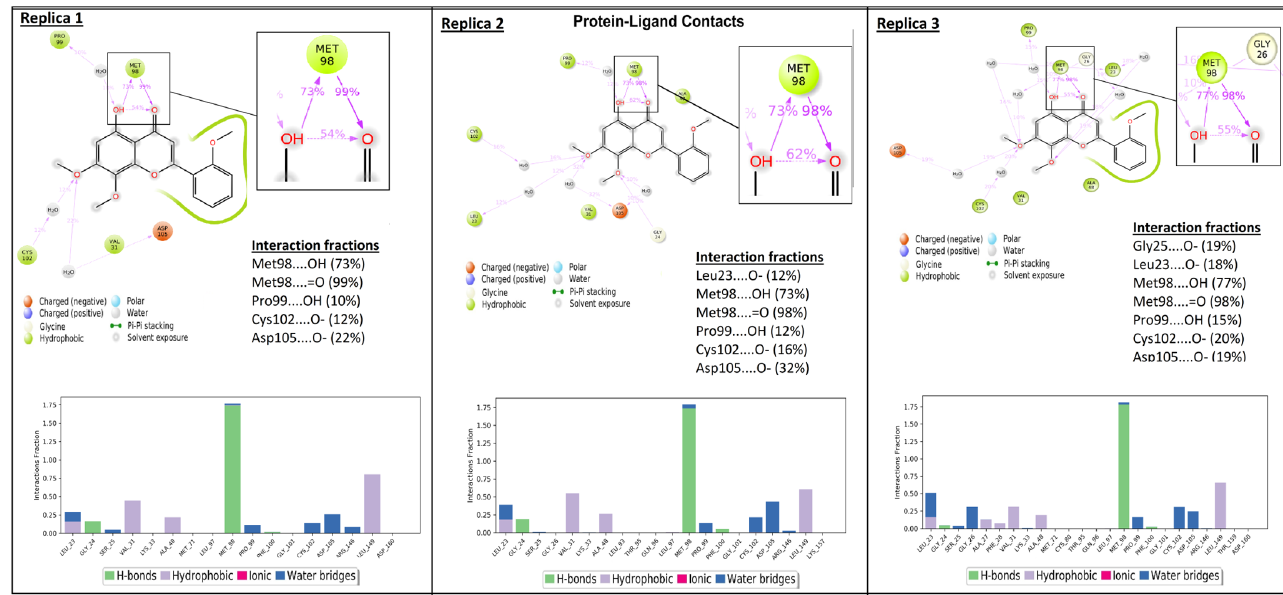
Figure 8. EGFR–Andrographin complex sustained intermolecular interactions and percentage interaction fraction throughout 100 ns production run.